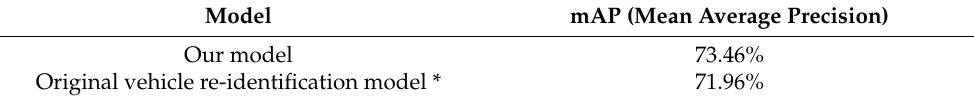
Table 2. Evaluation indicators of our vehicle re-identification model fused with lane features.